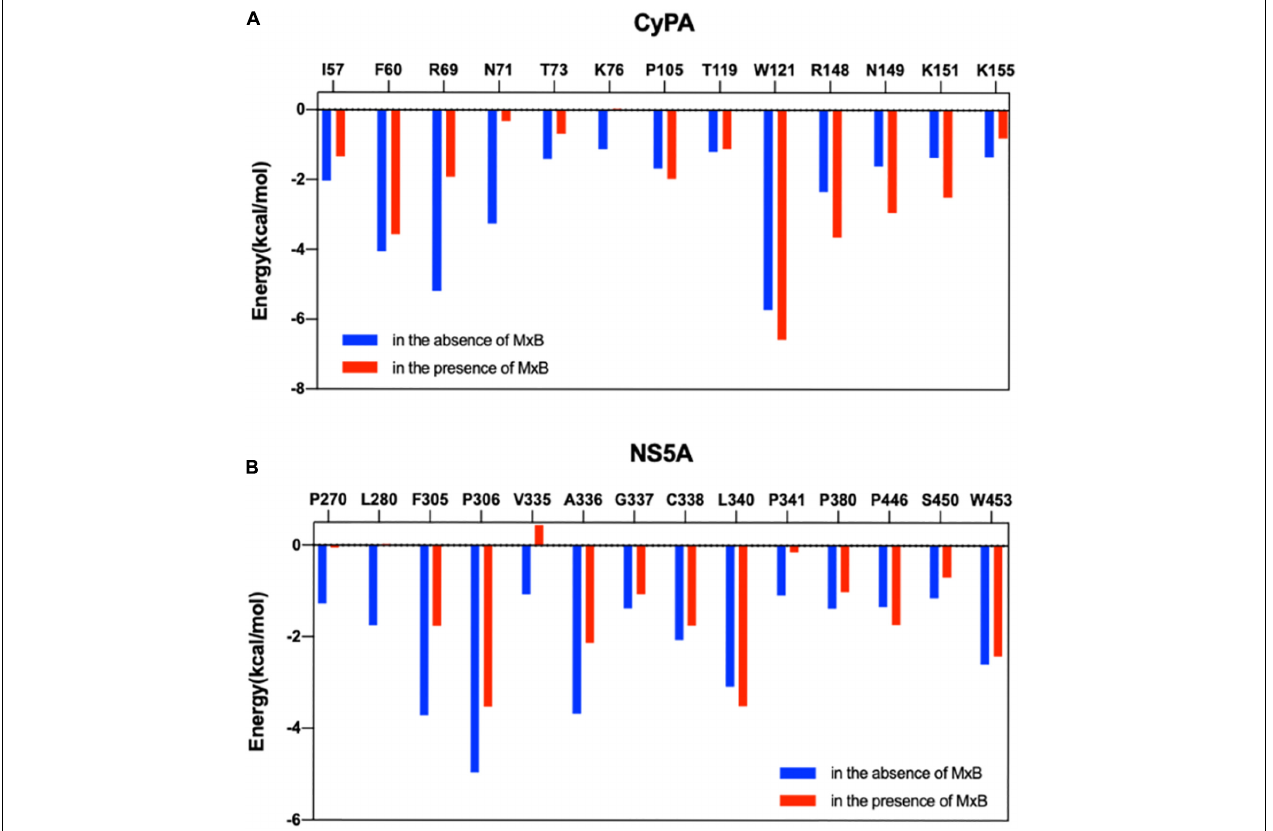
FIGURE 7 | Comparison of per-residue energy decomposition for key residues of CyPA:NS5A interaction in the absence (blue) and presence (red) of MxB. Residues highlighted are displayed for CyPA (A) and NS5A (B) . CypA, cyclophilin A; NS5A, non-structural protein 5A; MxB, myxovirus resistance B.